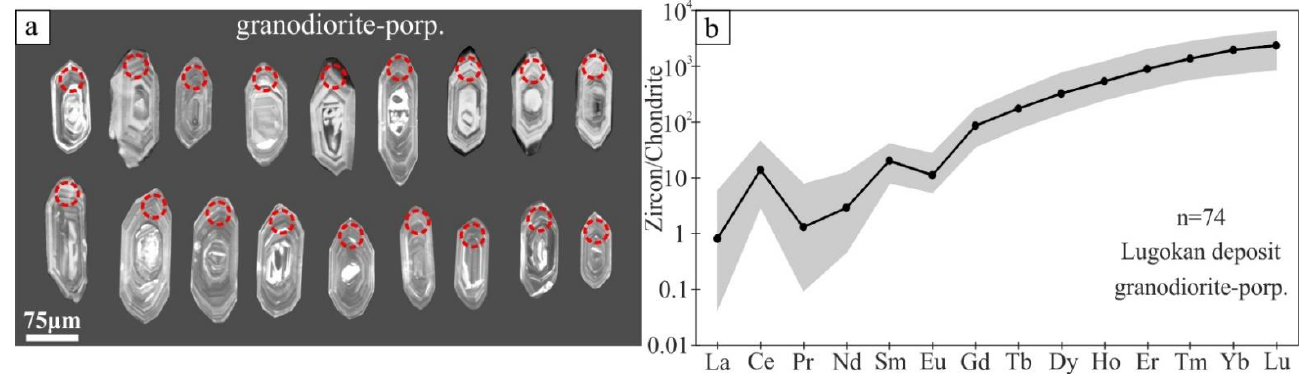
Figure 6. ( a ) — Cathodoluminescence (CL) images of representative zircon grains with laser spots (red circles) from the magmatic rocks of the Lugokan deposit; ( b ) — chondrite-normalized REE patterns for zircons from the magmatic rocks of the Lugokan deposit.